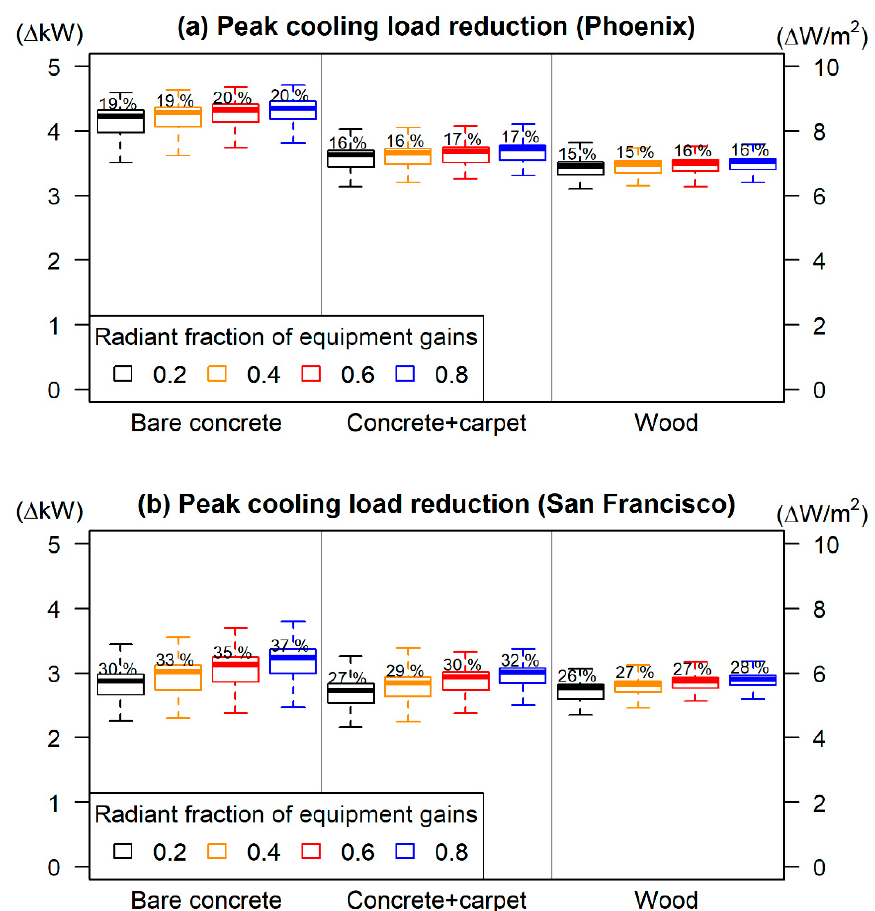
Figure 12. Sensitivity of a radiant fraction of equipment gains to the peak cooling load reduction for three floor configurations: Bare concrete, Concrete + carpet, and Wood in ( a ) Phoenix, AZ and ( b ) San Francisco, CA. The sum of the convective and radiant fractions stayed constant as one. The peak cooling load reductions were estimated during 106 weekdays from 1 June to 31 October. The percentage above a box indicates the median of relative reductions compared to the Base